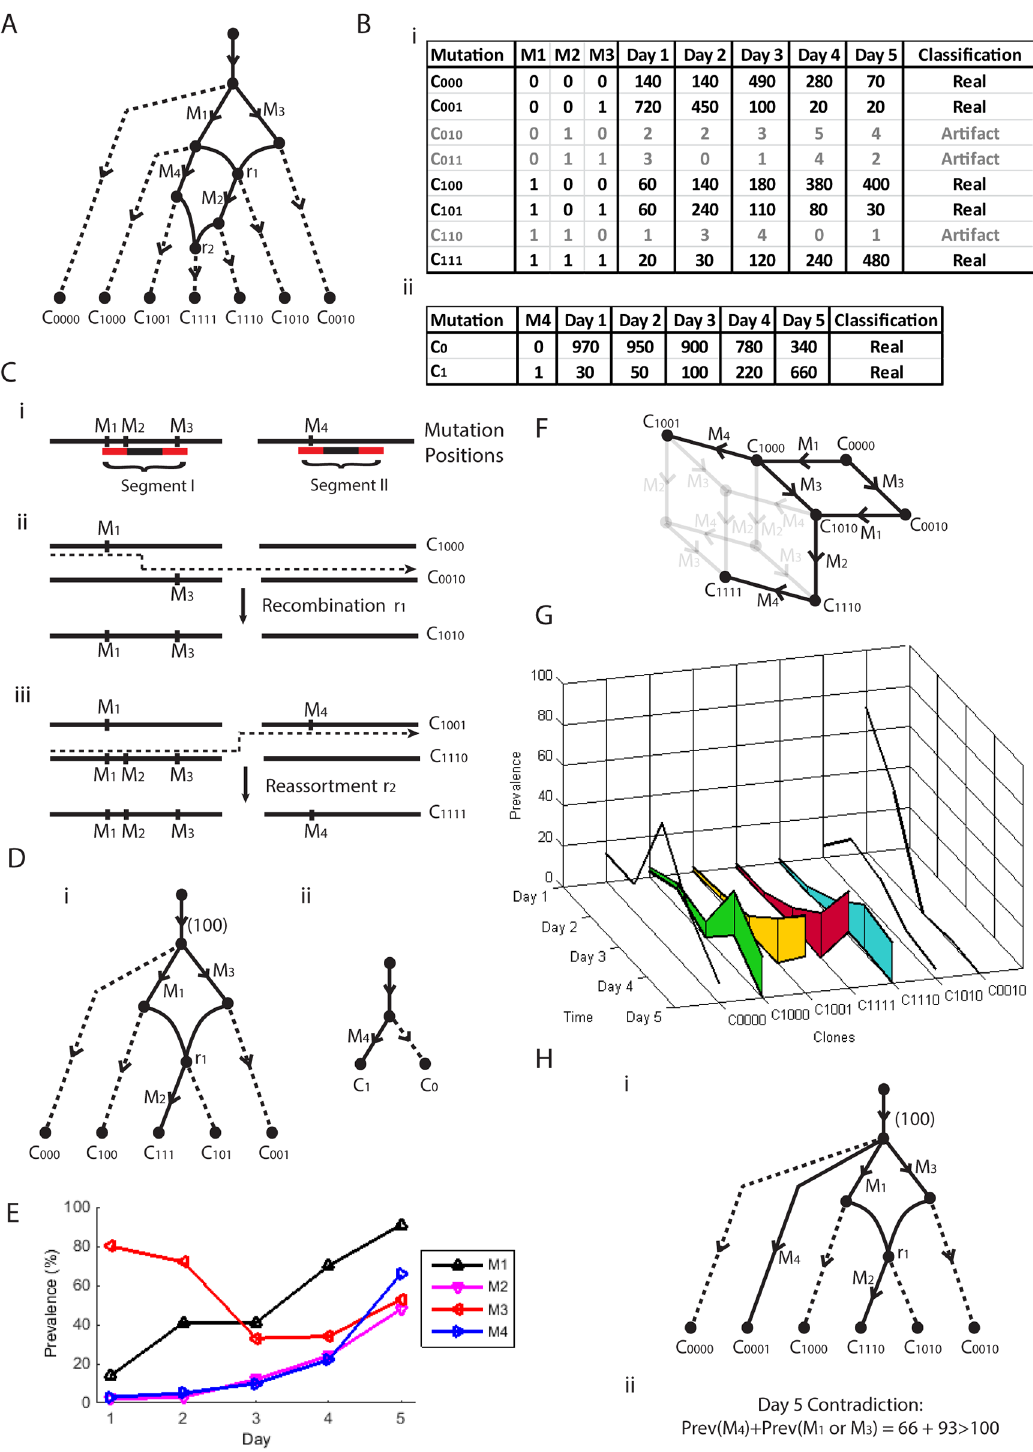
Fig 3. A super-network sample. (A) A pedagogic evolution recombination network with four mutations and two recombination events across two segments. (B) Typical haplotype tables arising from (A). (Ci) Two clusters of mutations grouped by paired reads on two segments. (Cii) Clones C 1000 and C 0010 undergo within segment recombination into C 1010 , with a crossover site between M 1 and M 3 . (Ciii) Clones C 1001 and C 1110 undergo between segment recombination (reassortment) into C 1111 . (D) Recombination networks arising from the haplotype tables in (B). (E) The prevalence of the four mutations across five days. (F) Phylogenetic network associated with (A). (G) Point and range prevalence estimates. (Hi) A network consistent with the two networks of (D). (Hii) Incompatible prevalence conditions associated with